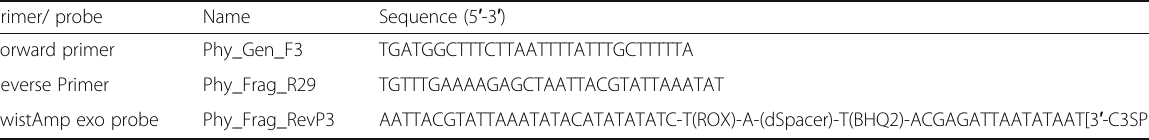
Table 1 Sequences of the optimal primers and probe for the RPA assay Primer/